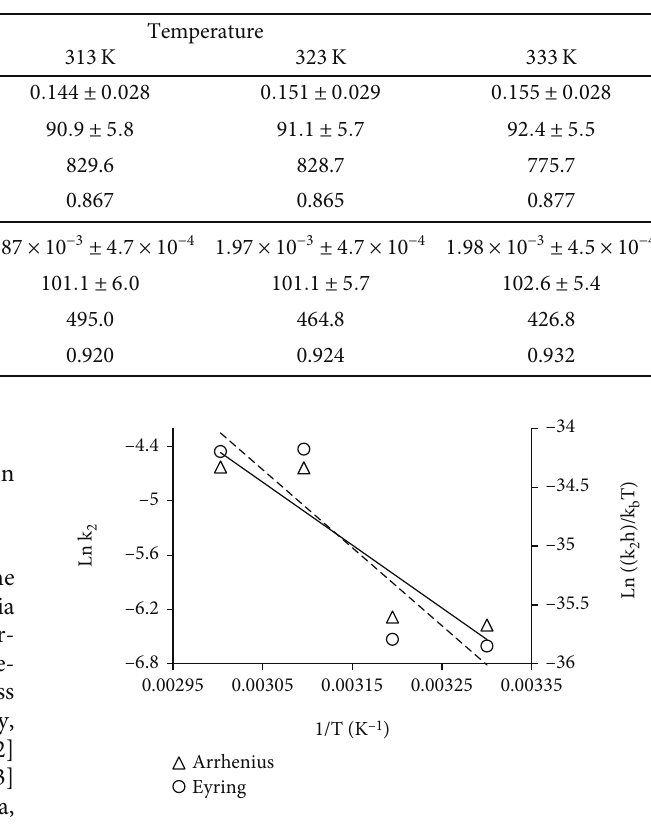
Figure 4: Pseudo- fi rst-order and pseudo-second-order adsorption kinetics for BF on GC (0.2 g GC, 150 mL of 400 mgL -1 BF, initial pH = 6 : 5 , stirring = 120rpm , di ff erent temperatures). Table 1: Kinetic parameters for the adsorption of BF on GC at di ff erent temperatures.